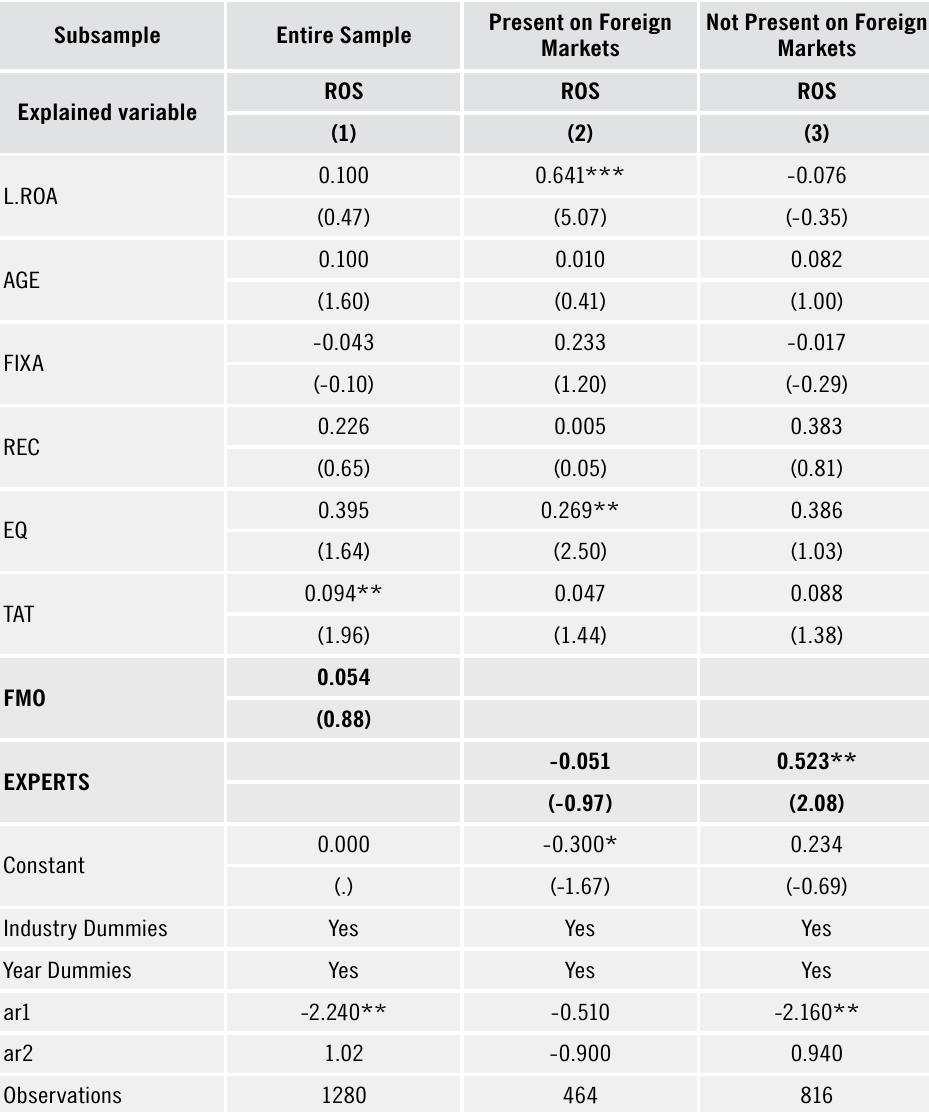
Table 11. Dynamic panel analysis of empirical relationship between international expert share and firm contemporaneous ROS Present on Subsample Entire Sample